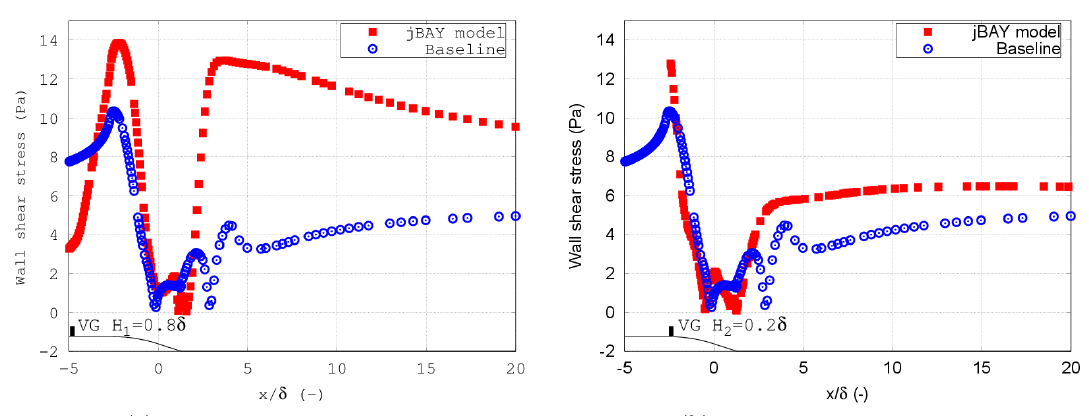
Figure 14. Wall shear stress distribution along the measurement line B. Red rectangles represent the data (jBAY model) obtained from the jBAY Source Term Model implemented and the blue circles the data (Baseline) obtained from the CFD simulation for the baseline case. The two vane-type VG cases are plotted. VGs, flat plate and ramp are also shown (not at